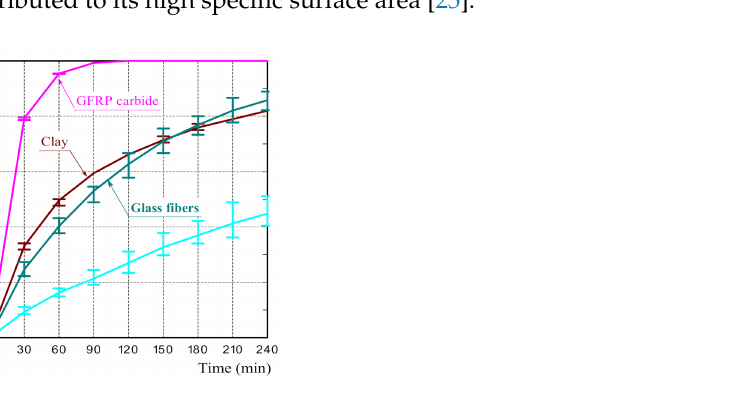
Figure 8. The reduction rates of NO 2 concentration on the glass fiber and GFRP carbides.